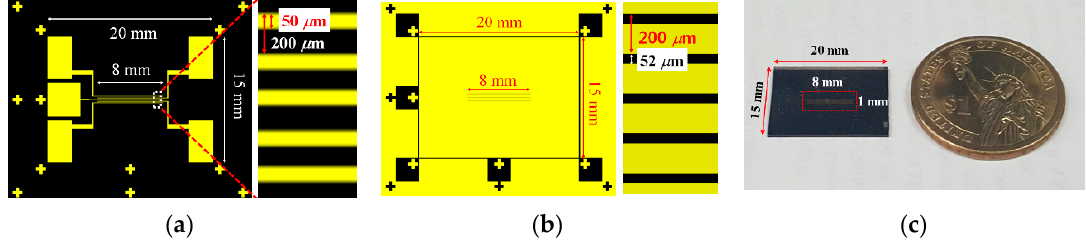
Figure 5. CAD images of photo-lithographic masks with the alignment marks for ( a ) ITO patterning and ( b ) Al slit patterning; ( c ) Image of the fabricated DFPG device. and ( b ) Al slit patterning; ( c ) Image of the fabricated DFPG